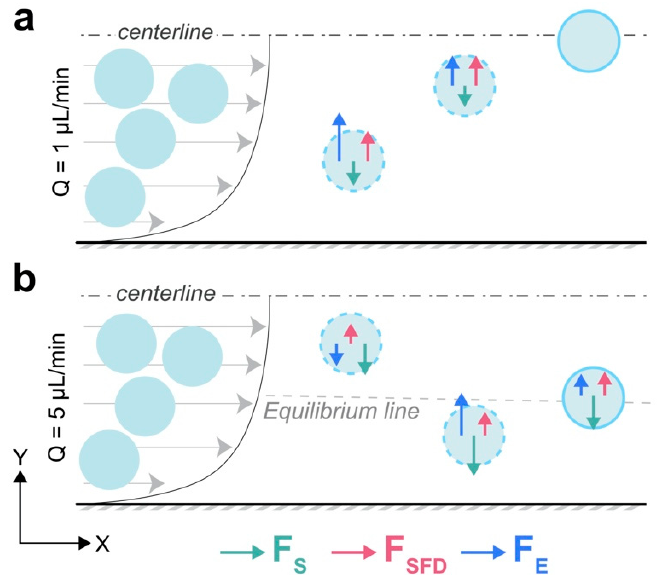
Figure 8. General focusing mechanisms of particles in the Y-midline of a rectangular channel in viscoelastic fluid flow. Final stable equilibrium position of particles is determined by the balance of the shear-gradient (F S ), N 2 -induced secondary flow transversal drag (F SFD ), and the elastic (F E ) forces at ( a ) Q = 1 µL/min ( Wi = 3.6), and ( b ) Q = 5 µL/min ( Wi = 18). Dashed circles indicate particles migrating towards the equilibrium position; solid circles are particles at final, stable equilibrium position.